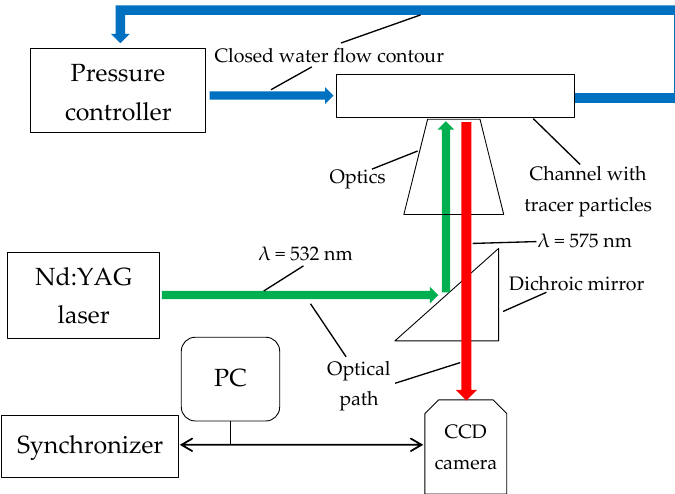
Figure 3. Principal scheme of μPIV system .